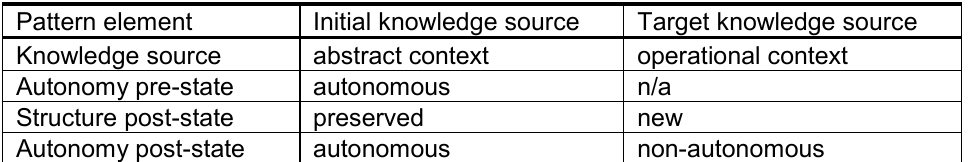
Table 3. Instantiated fusion